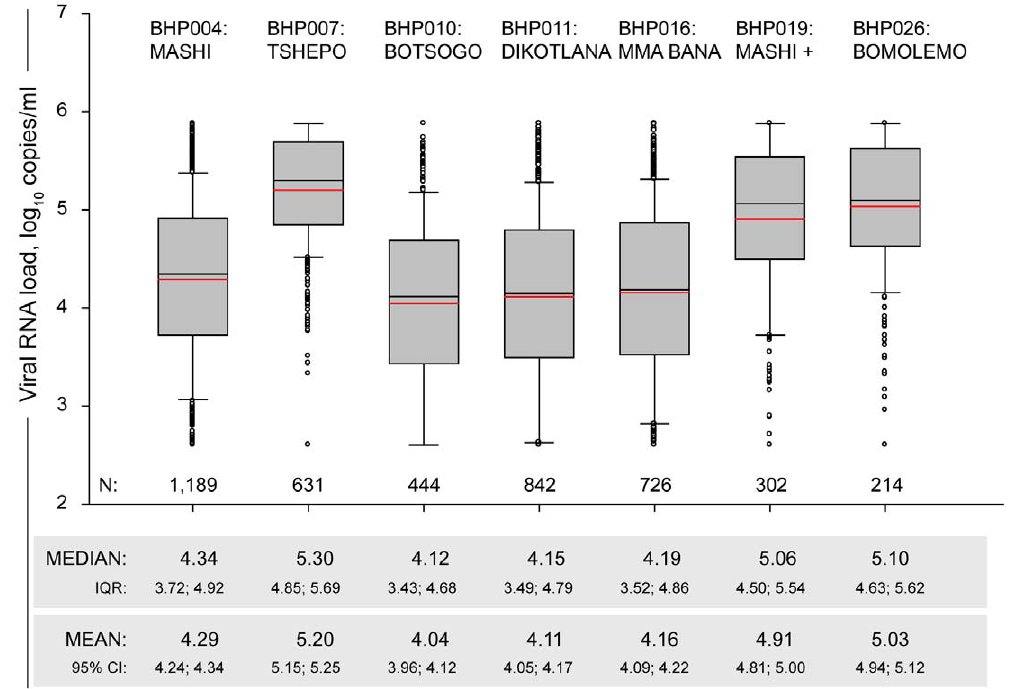
Figure 1. HIV-1 subtype C RNA levels in seven BHP cohorts (pre-cART baseline data). In the box plots, the boundary of the box closest to zero indicates the 25 th percentile, a black line within the box marks the median, a red line within the box marks the mean, and the boundary of the box farthest from zero indicates the 75 th percentile. Whiskers above and below the box indicate the 10 th and 90 th percentiles. Points above and below the whiskers indicate outliers outside the 10 th and 90 th percentiles. Text above each box plot indicates the BHP study number and the name of the corresponding cohort. Numbers of included participants per cohort are shown at the bottom within the graph. Median, IQR, mean, and 95% CI are presented at the bottom outside the graph.